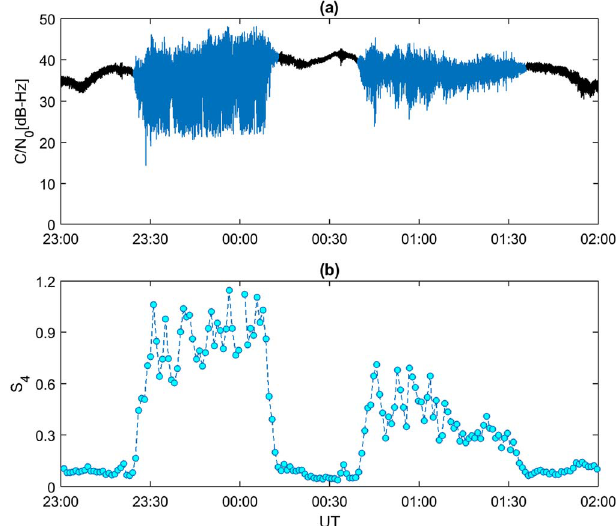
Fig. 2. GPS example of received signal for PRN 28 in the night between 14 and 15 of December of 2001. (a) GPS signal affected by ionospheric bubbles in blue. (b) The respective S 4 index